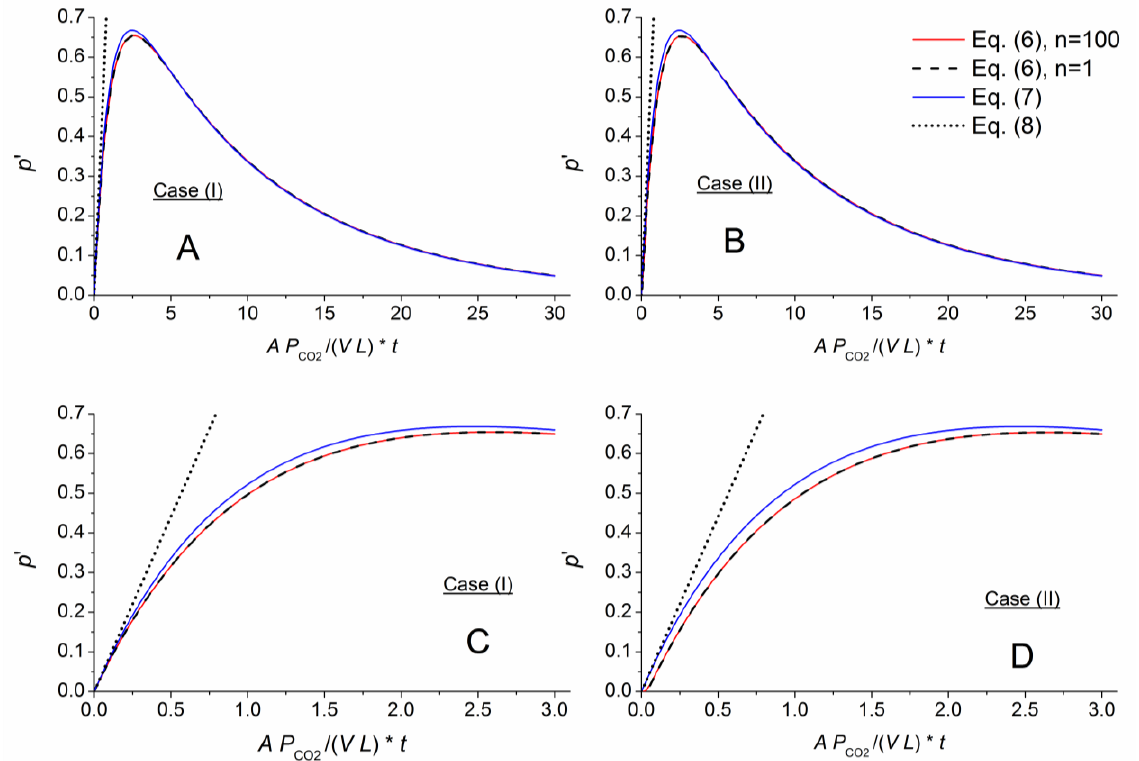
Figure 3. Comparison of the exact solution (Equation (6), 100  n ) for  VAL / 0.1 with the approximations: Equation (6) for 1  n , the thin-layer solution Equation (7), and its linear approximation Equation (8). The long-term pressure development occurring after the outer air matrix is replaced with CO is shown above. A plot for short times is shown 2